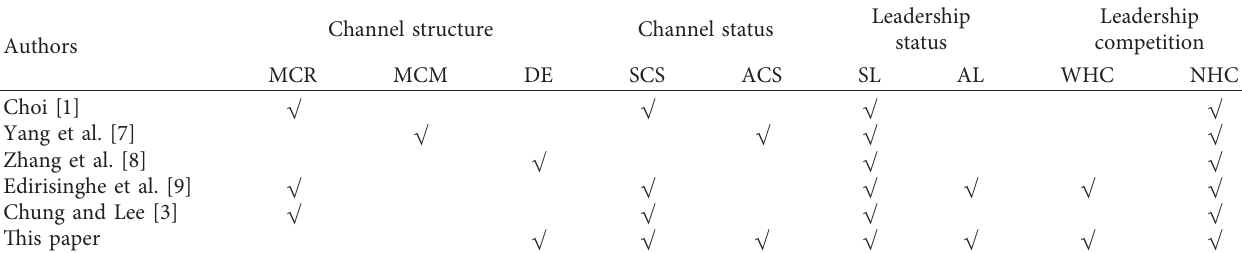
Table 1: Comparison of previous models with the current